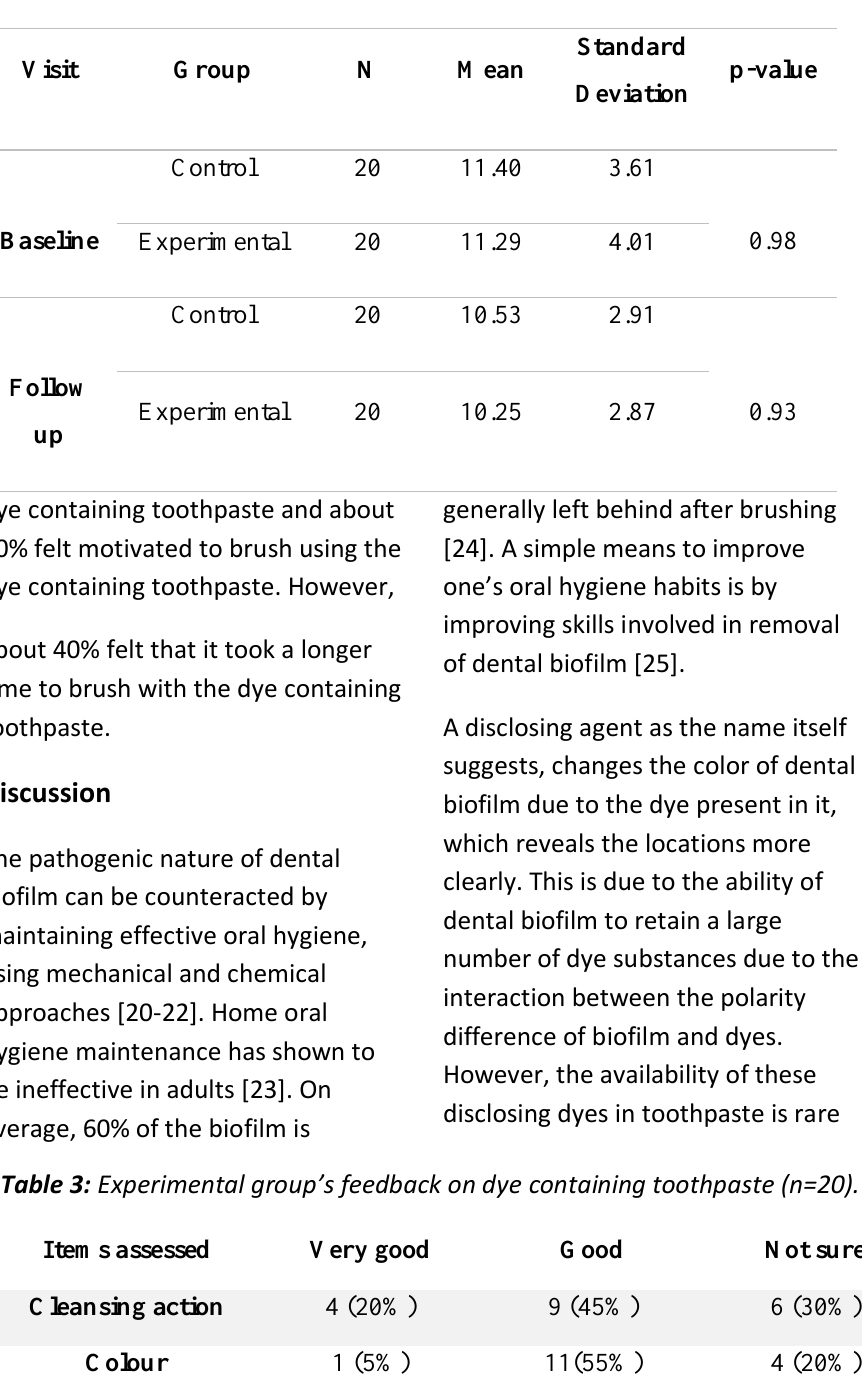
Table 2. Comparison of Mean DPIA scores between Control and Experimental Groups.